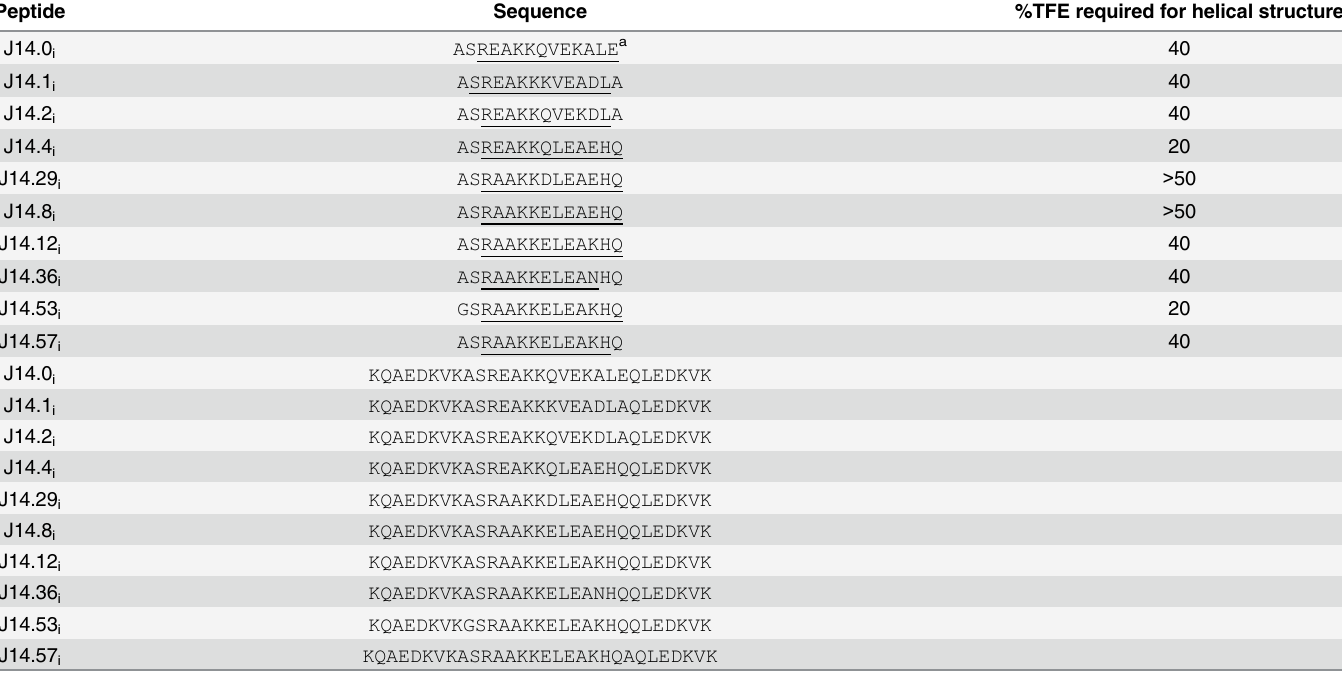
Table 2. Peptides used in the